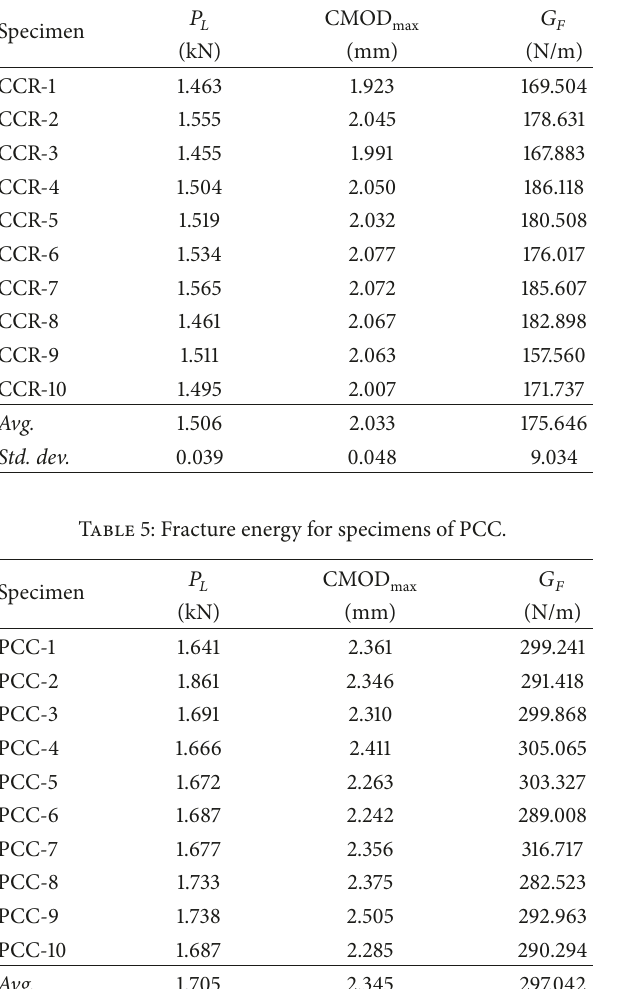
Figure 13: PCC concrete. Table 4: Fracture energy for specimens of CCR.